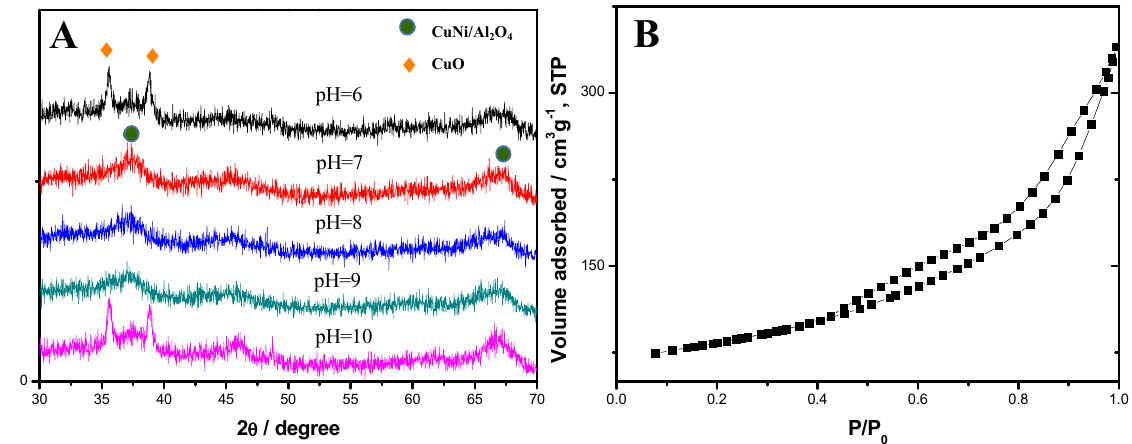
Figure 1. ( A ) XRD patterns of the Cu-Ni/Al 2 O 4 samples synthesized under different pH conditions, and ( B ) nitrogen adsorption-desorption isotherms of the Cu-Ni/Al 2 O 4 samples synthesized under pH 9.0. (Note that calcination temperature is 600 °C for all samples).